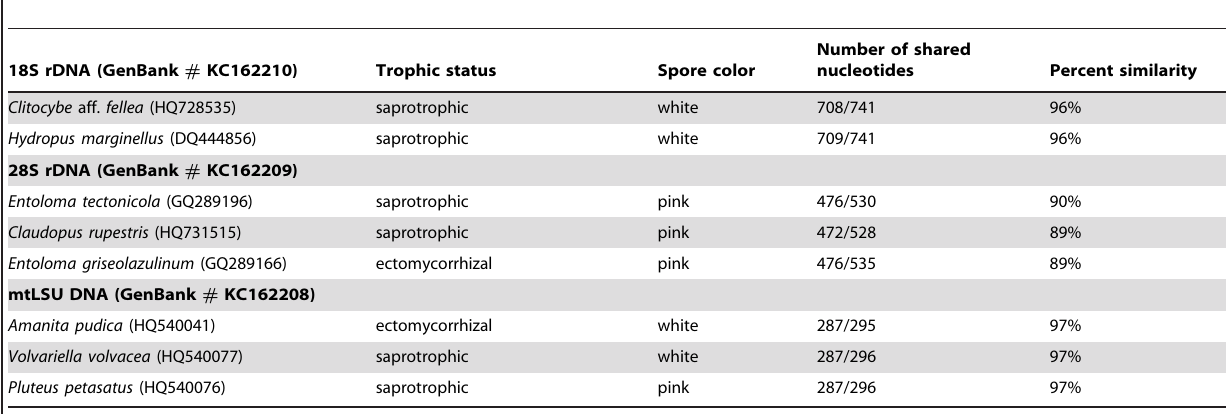
Table 3. Affinities of Agaricales TH9235 based on BlastN analysis of three gene regions (18S rDNA, 28S rDNA, mtLSU).